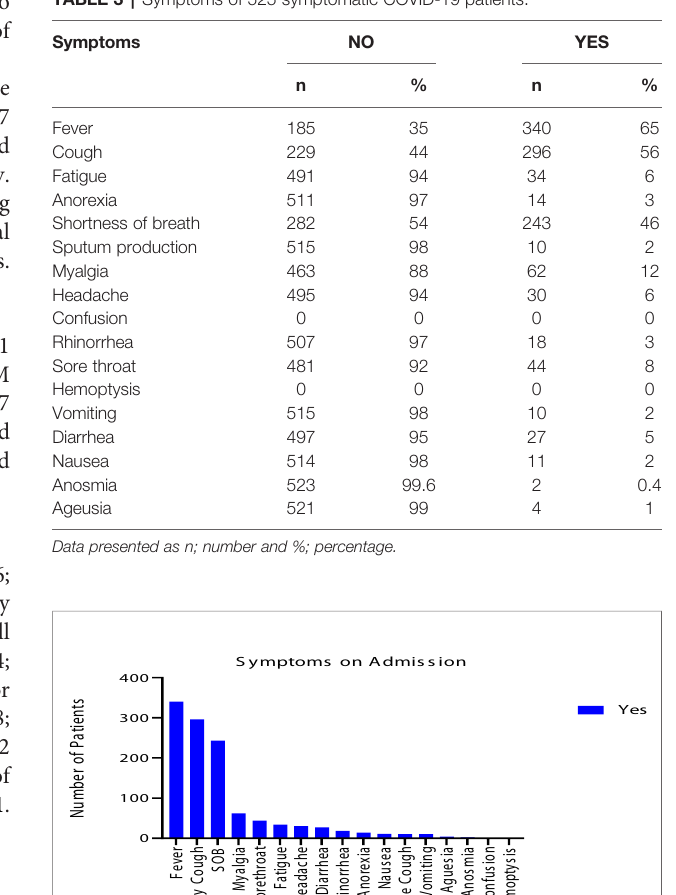
TABLE 3 | Symptoms of 525 symptomatic COVID-19 patients.